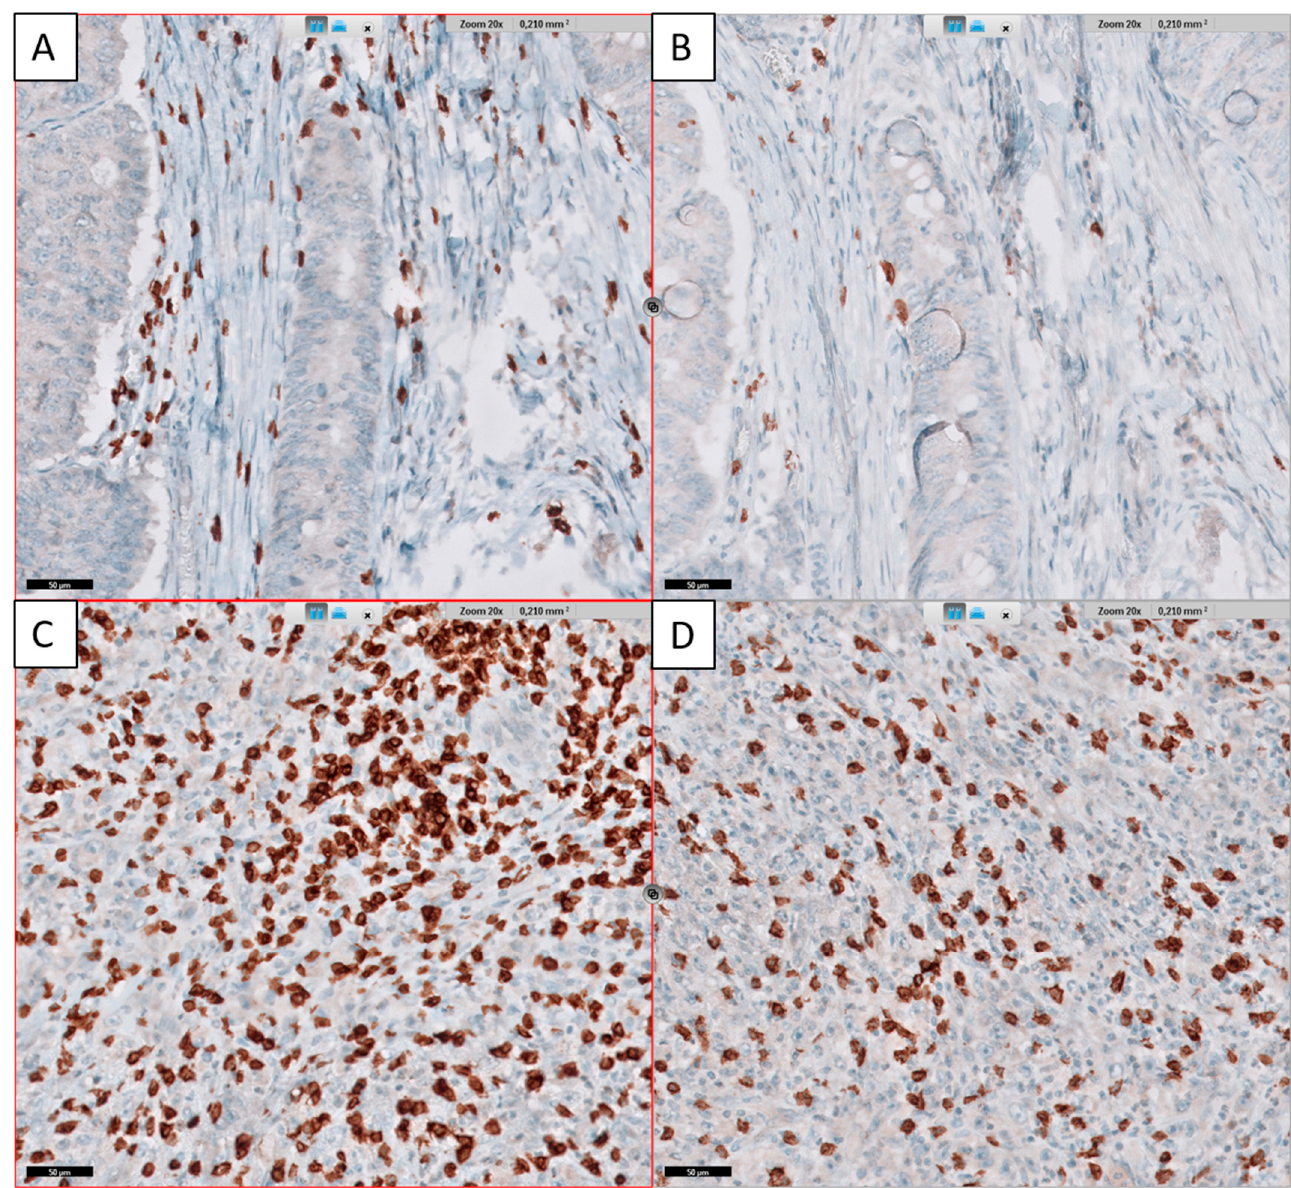
Figure 2. Immunohistochemical staining of tumor-infiltrating lymphocytes in the tumor center. CD3 lymphocytes ( A ) and CD8 lymphocytes ( B ) in a patient with low lymphocyte infiltration. CD3 lymphocytes ( C ) and CD8 lymphocytes ( D ) in a patient with high lymphocyte infiltration. Scale bar indicates 50 µm.